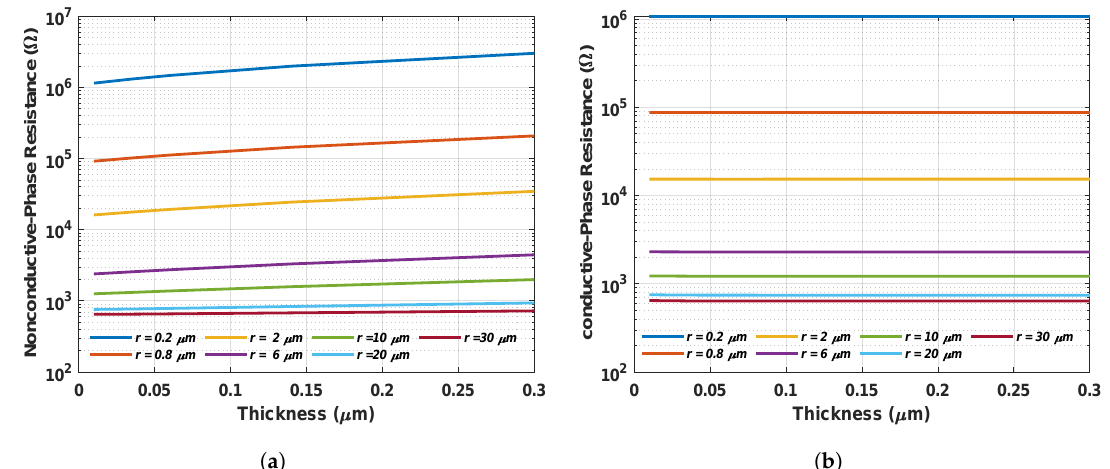
Figure 11. VO 2 resistance during ( a ) the nonconductive phase and ( b ) during the conductive phase at different